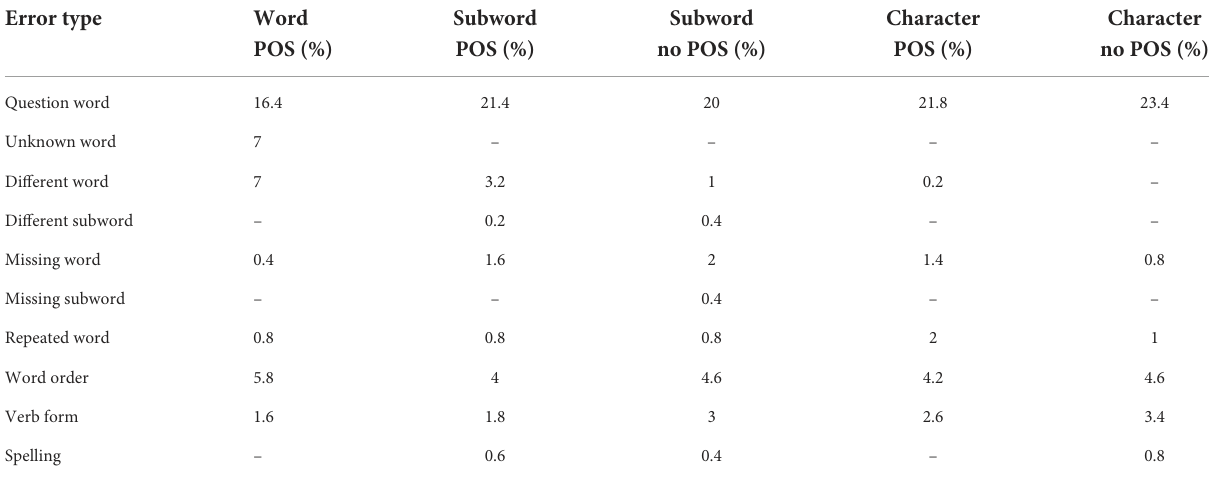
TABLE 4 Distribution of error types in the 500 samples for models trained on unclean